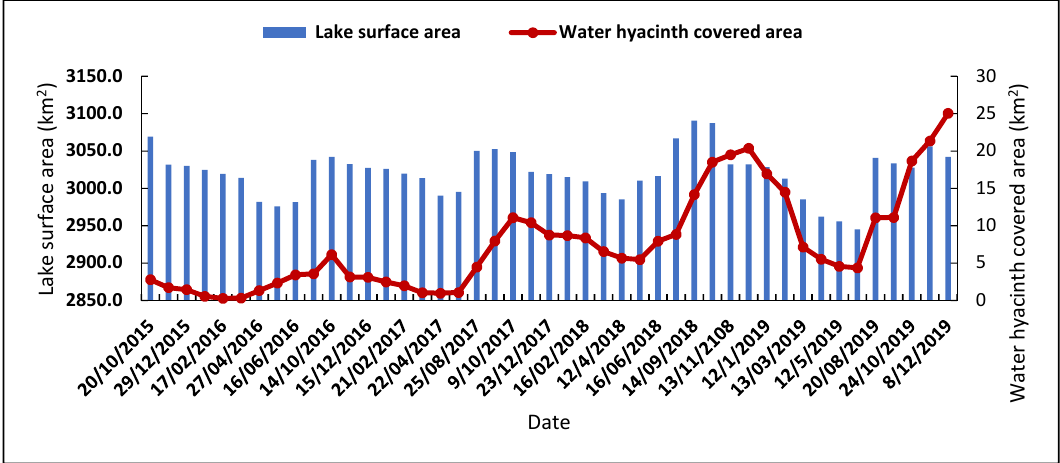
Figure 3. Monthly graphical presentation of water hyacinth covered area and lake surface area since 2015.